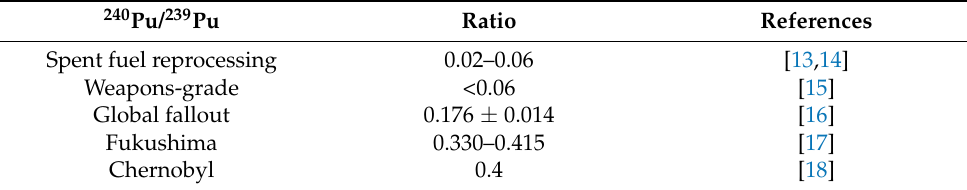
Table 2. Pu isotope ratios in pollution from different nuclear